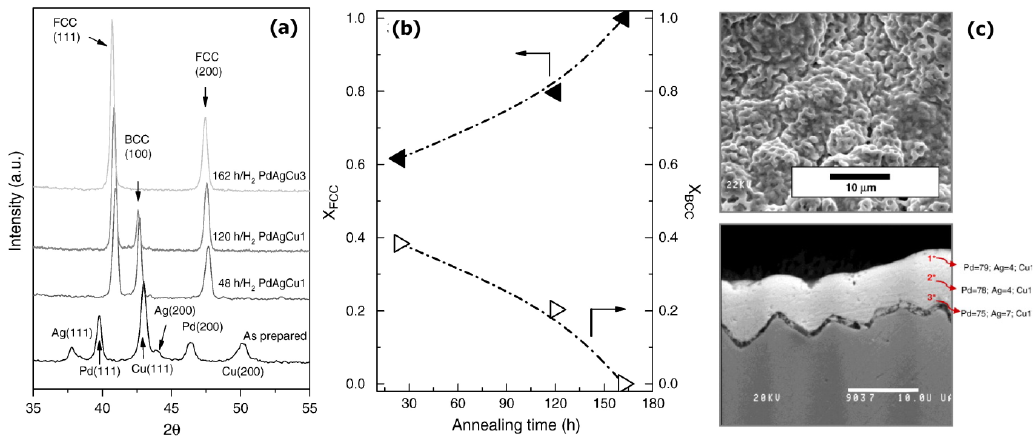
Figure 13. Ternary PdAgCu alloy formation: ( a ) XRD patterns after annealing up to 500 °C in H 2 at different times, ( b ) Microstructure evolution with annealing time and ( c ) SEM images after annealing of both top surface and cross-section [224], with permission from © Elsevier.